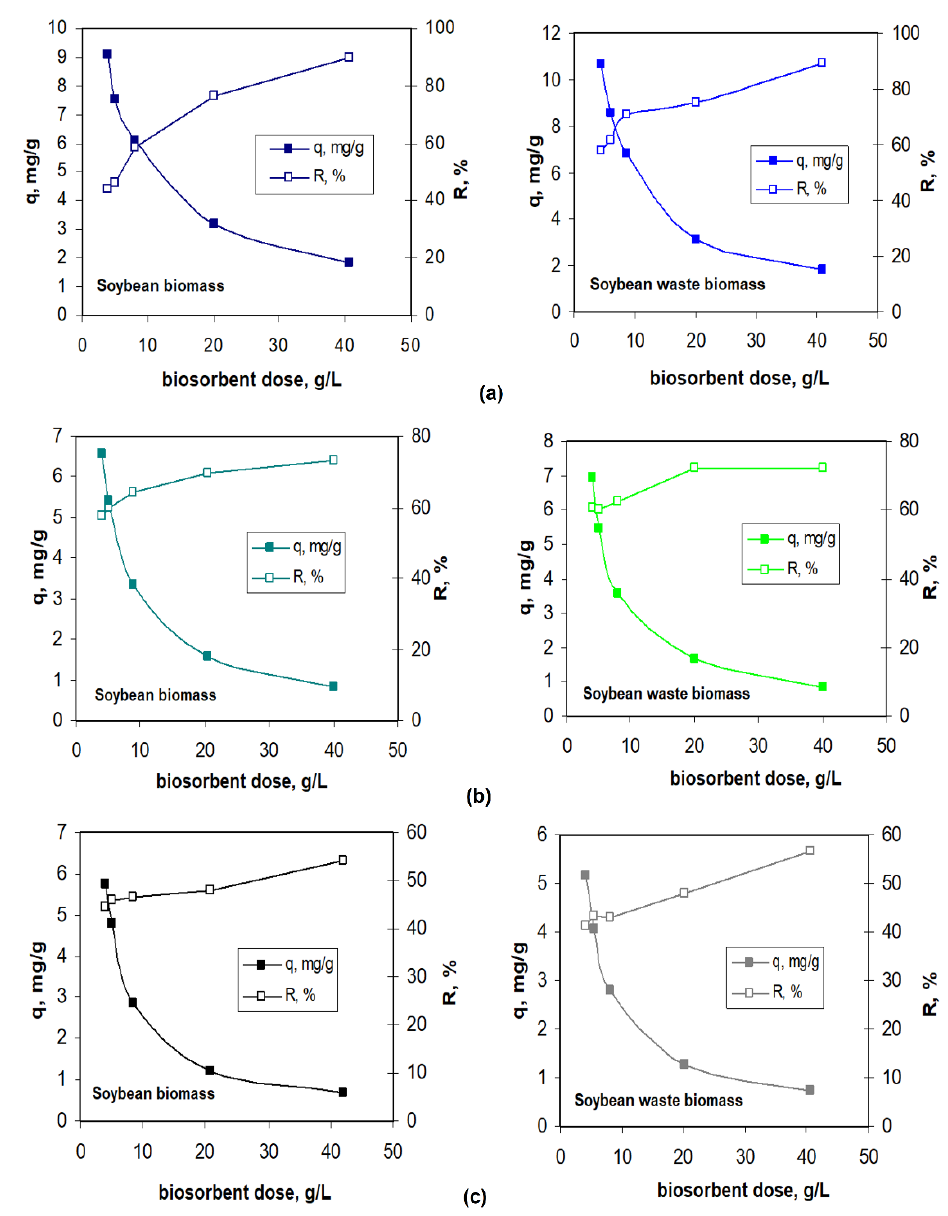
Figure 5. Influence of biosorbent dose on the biosorption efficiency of ( a ) Pb(II), ( b ) Cd(II), and ( c ) Zn(II) ions on soybean biomass and soybean waste (pH = 3.39; c 0 = 46.11 mg/L; contact time = 24 h; temperature = 22 °C).